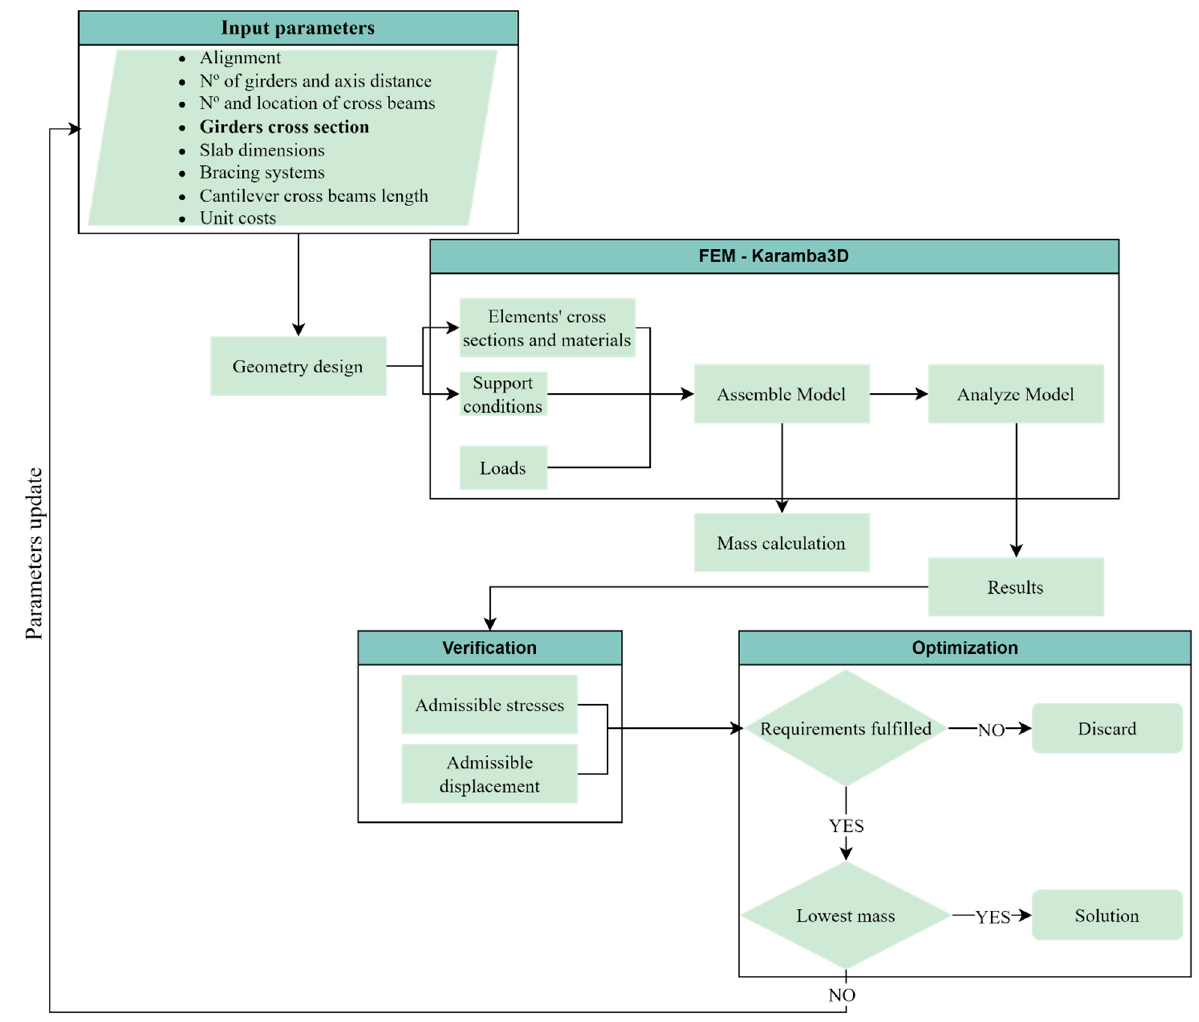
Figure 13. Generative design and optimization process fl owchart.